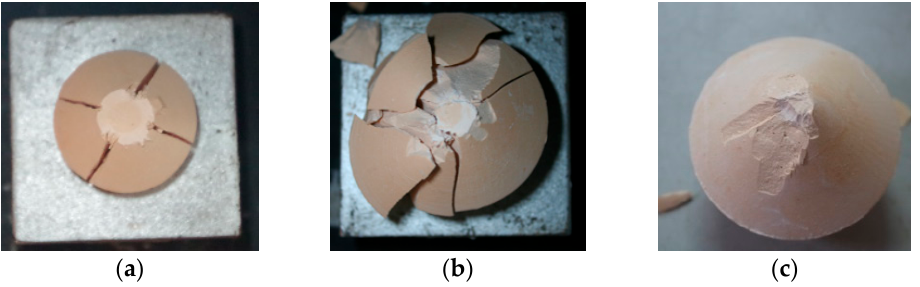
Figure 10. Breakage modes change with the increase in sphere diameter D when cone angle θ is 90 ° and contact diameter is 8 mm: ( a ) D = 30 mm; ( b ) D = 50 mm; ( c ) D = 70 mm.